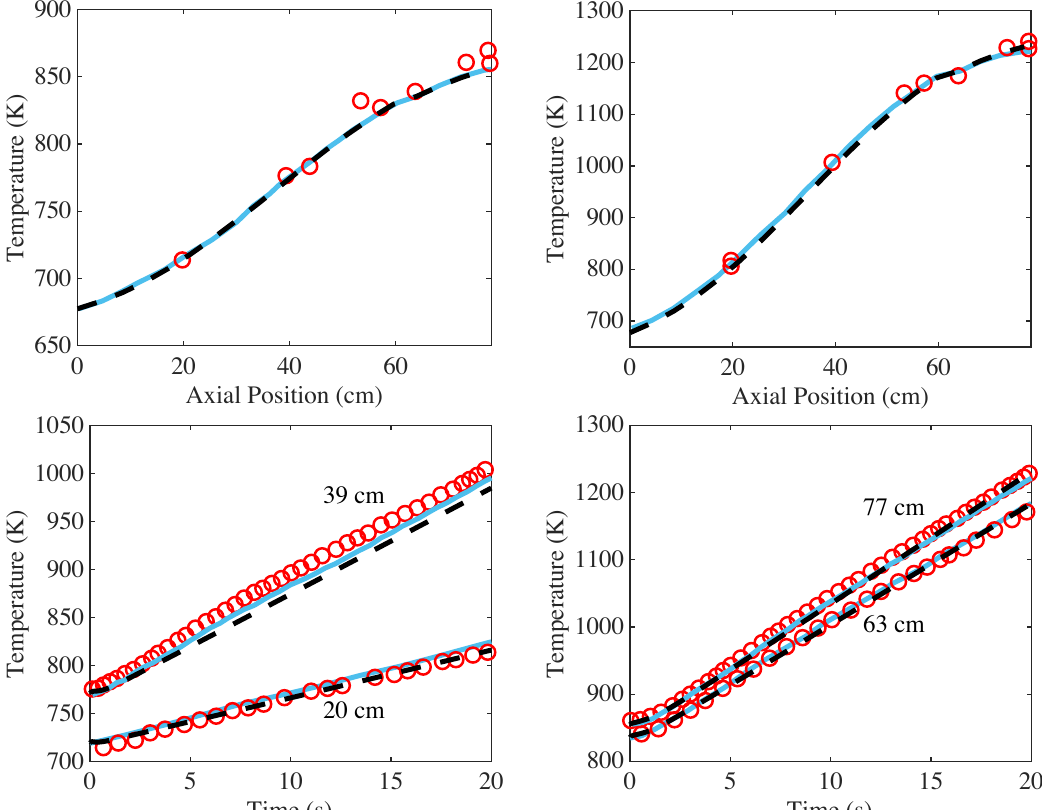
Figure 2. Coolant temperature profiles. (top left) Temperature at steady state prior to the loss of flow event. (top right) Coolant temperature 20 seconds after the loss of flow event begins. (bottom left) Coolant temperature at 20 cm and 39 cm axial positions. (bottom right) Coolant temperature at 63 cm and 77 cm axial positions. Experimental results shown by red circles in the steady-state data are discrete, in the temporal data they are continuous, SAS-SFR results are shown by the solid blue curve, and our results are shown by the dashed black